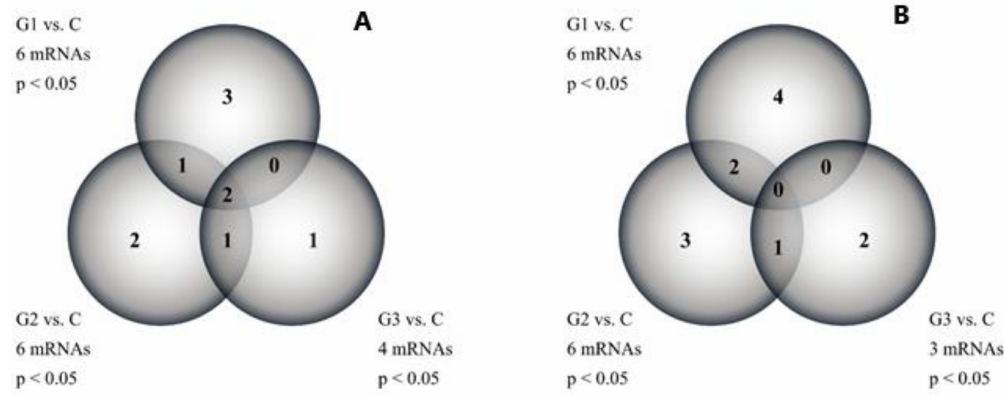
Figure 1. Venn diagram of the results obtained with the microarray method. ( A )—tissue samples; ( B )—whole blood; C, control; and G, endometrial cancer grade; p < 0.05 vs. C group; mRNA—messenger RNA. Table 3. Expression profile of LEP, LEPROT, LEPROTL1, and LEPR in the endometrial tissue samples and whole blood of patients determined by microarrays and RT-qPCR ( p < 0.05; FC > 3 or < − 3).